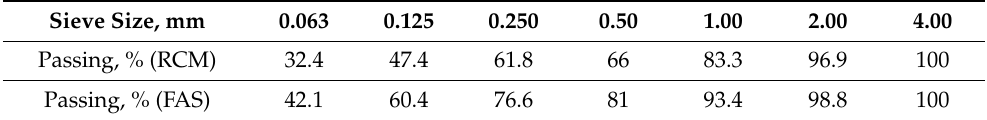
Table 2. Sieving results of the recycled cement mortar (RCM) and the fly ash–slag mix